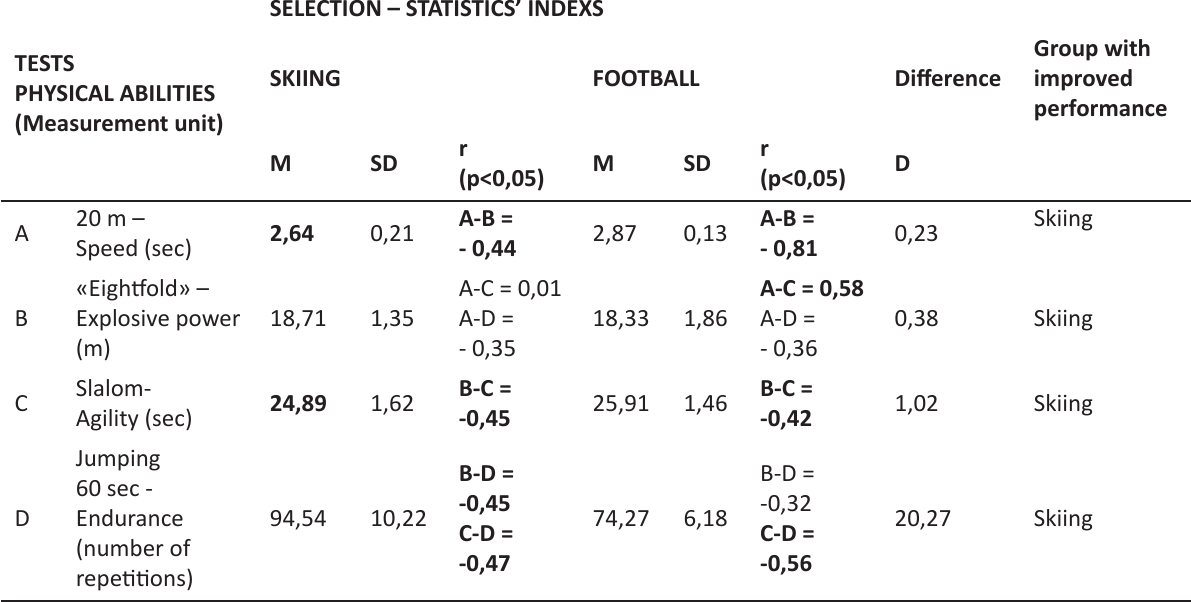
Table 4. Comparison of physical abilities between selection skiing and football teams